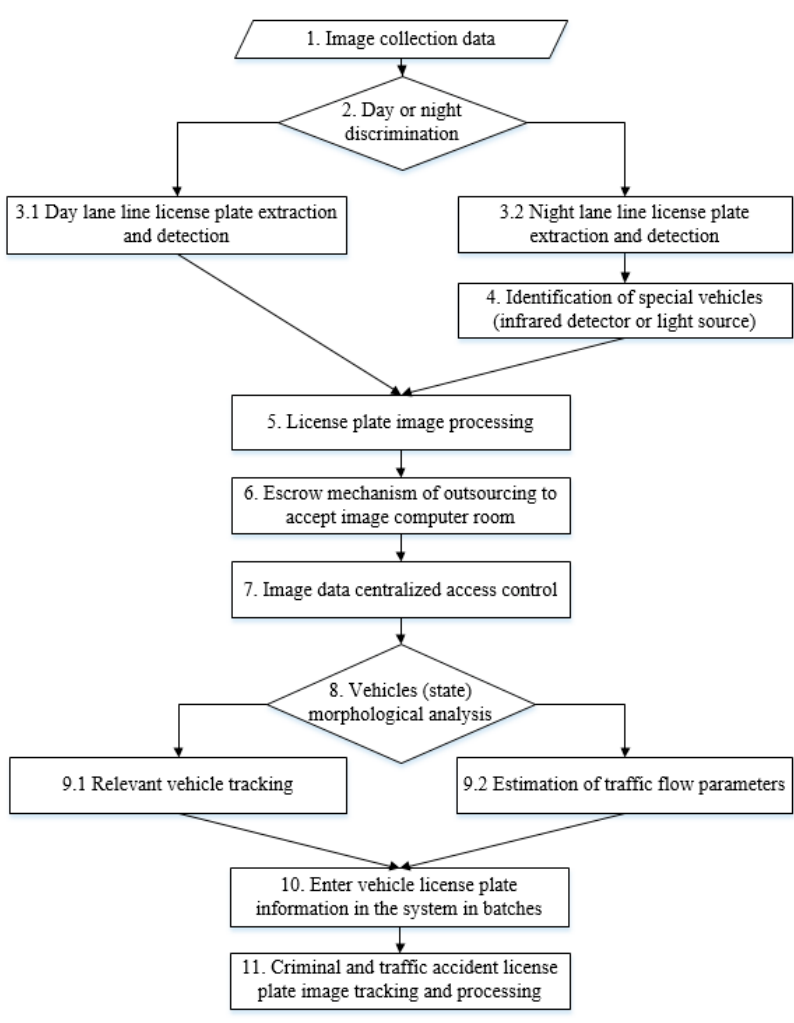
Figure 2. Flowchart of the proposed ICTVSS model in modularization steps.